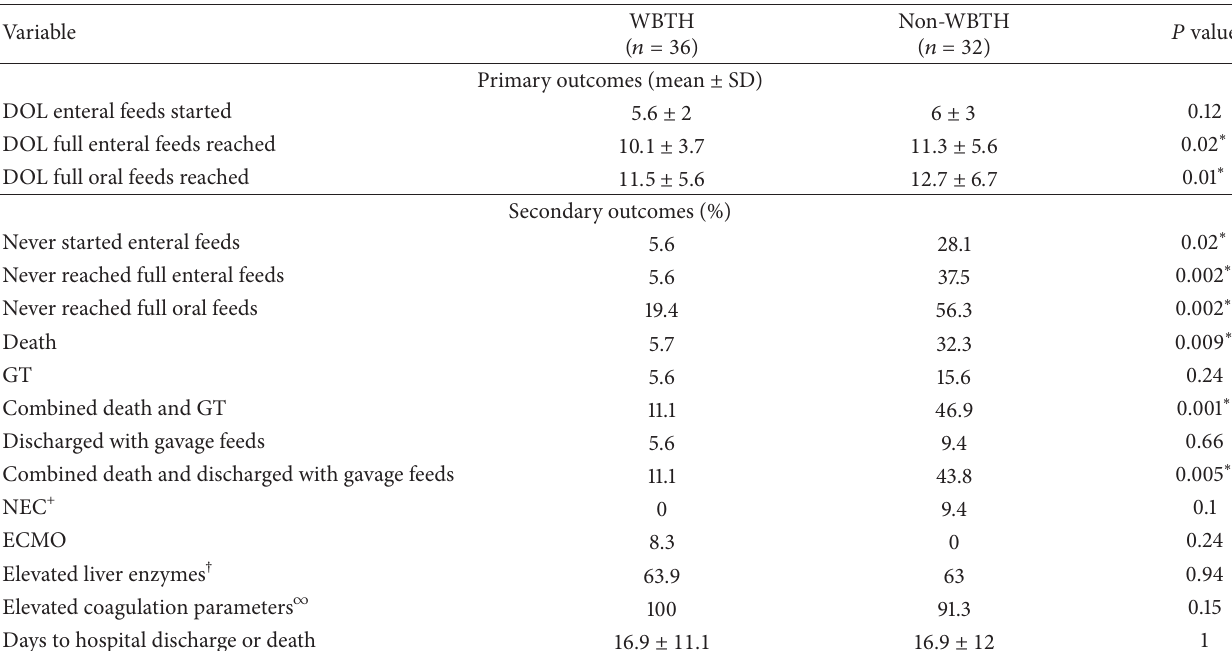
Table 2: Primary and secondary outcome variables for strict criteria group.